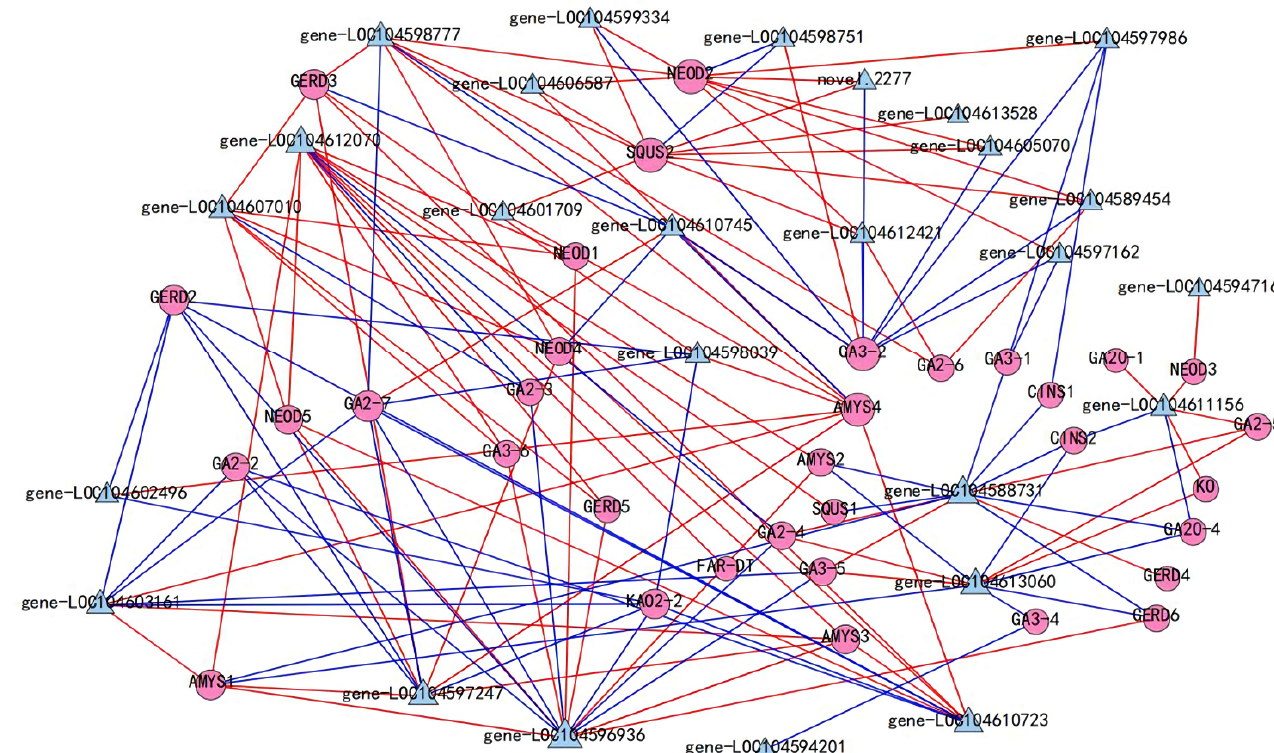
Figure 7. Correlation analysis of TPS genes and WRKY transcription factors (Pearson correlation coefficient > 0.8). The circular nodes are TPS genes, the triangular nodes are WRKY, the red line represents positive correlation, and the blue line represents negative